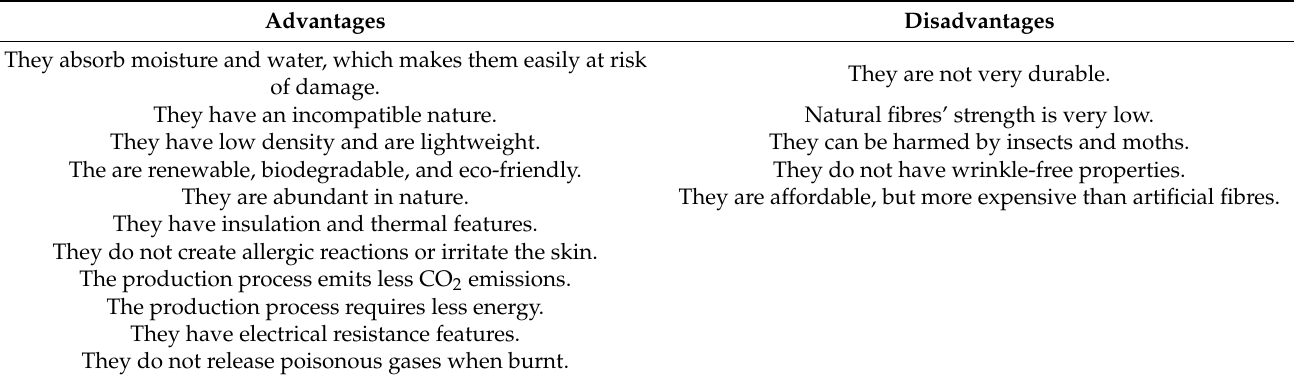
Table 1. The advantages and disadvantages of natural